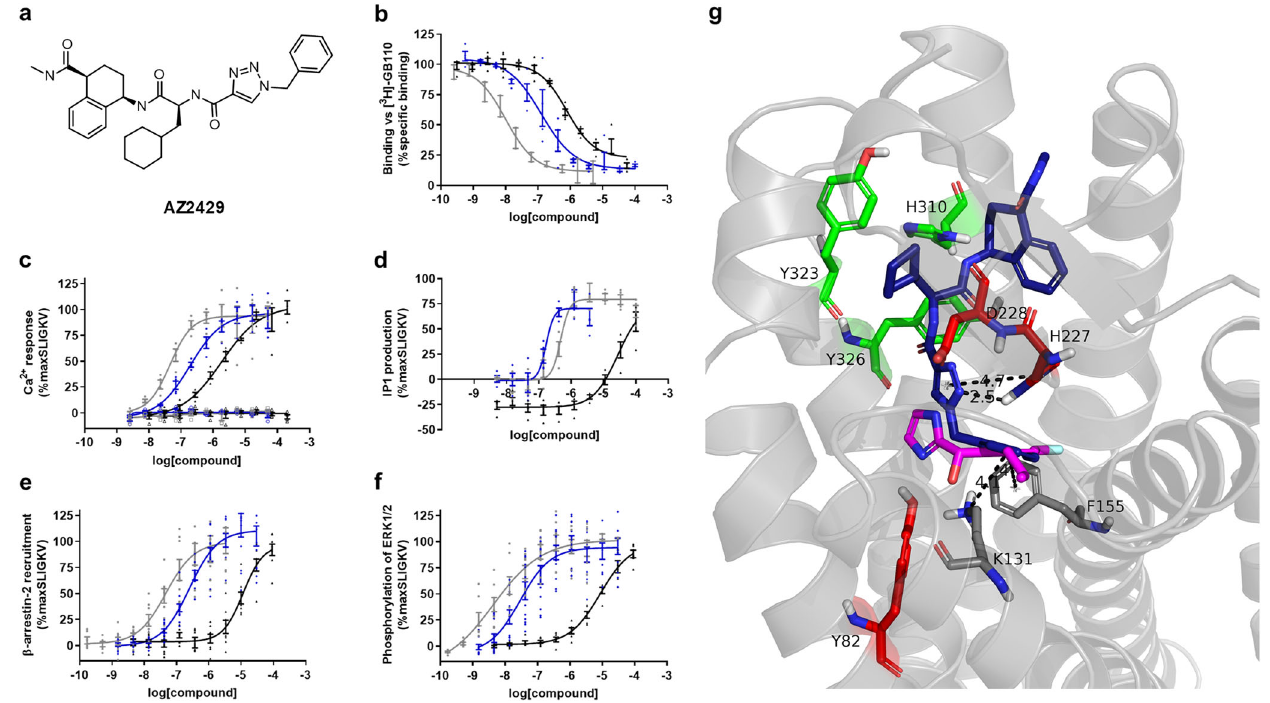
Fig. 2 AZ2429 binds to PAR2 and activates multiple signalling pathways. a Chemical structure of most active enantiomer of the potent agonist compound (AZ2429). AZ2429 (blue) and known PAR2 agonists SLIGKV-NH 2 (black) and GB110 (grey) were pharmacologically pro fi led for: b competitive binding against [ 3 H]-GB110 in membrane preparations of HEKexpi293 cells overexpressing human PAR2; c Ca 2 + mobilisation and d IP1 production in 1321N1-hPAR2 cells; as well as e β -arrestin-2 recruitment and f phosphorylation of ERK1/2 in U2OS-hPAR2 cells. No agonistic effects were detected in parental 1321N1 cells, exempli fi ed in the Ca 2 + assay (open symbols). Agonist responses were calculated as % maximum response of SLIGKV-NH 2 . Graphs show representative data of 2 or more experiments, presented as individual data points with error bars denoting the s.e.m. The comprehensive pharmacological data are stated in Table 2. g Re fi ned model of AZ2429 (blue) in the PAR2 receptor generated through molecular docking calculations in an adapted model of the PAR2 structure. Superimposed is AZ8838 (magenta) from the crystal structure (PDB 5NDD) showing the overlap of the benzyl substituents of each compound. Important receptor side chains are colour-coordinated based on their spatial localisation.